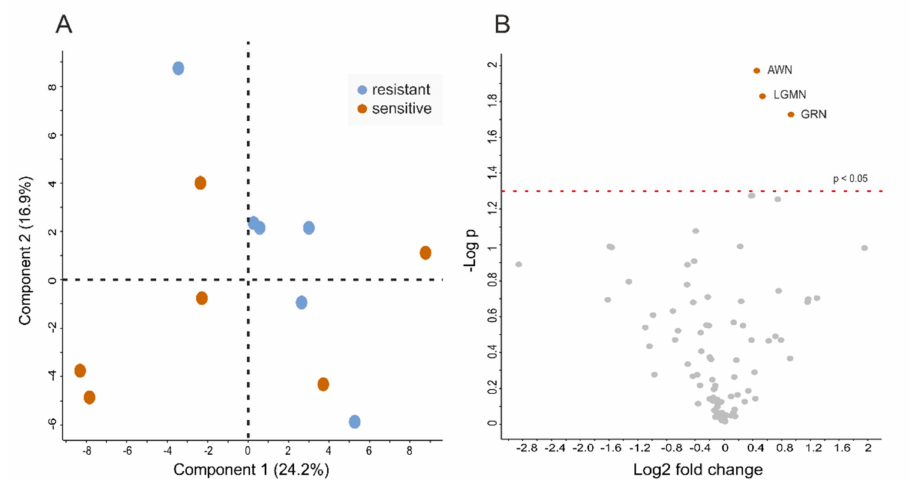
Figure 5. Exploratory data analysis of proteins identified in seminal plasma of boars showing high sperm quality (resistant) and low sperm quality (sensitive) in stored semen doses containing 10% ( v / v ) autologous seminal plasma. Overview of the results from the LC-MS / MS analysis of boar seminal plasma proteins. ( A ) Principal component analysis (PCA) of normalised protein intensity values shows no distinct separation of the two groups, whereas ( B ) volcano plot analysis reveals three di ff erently abundant protein candidates ( p < 0.05) in seminal plasma samples collected from ejaculates with resistant (blue boxes) and sensitive (orange boxes) sperm.